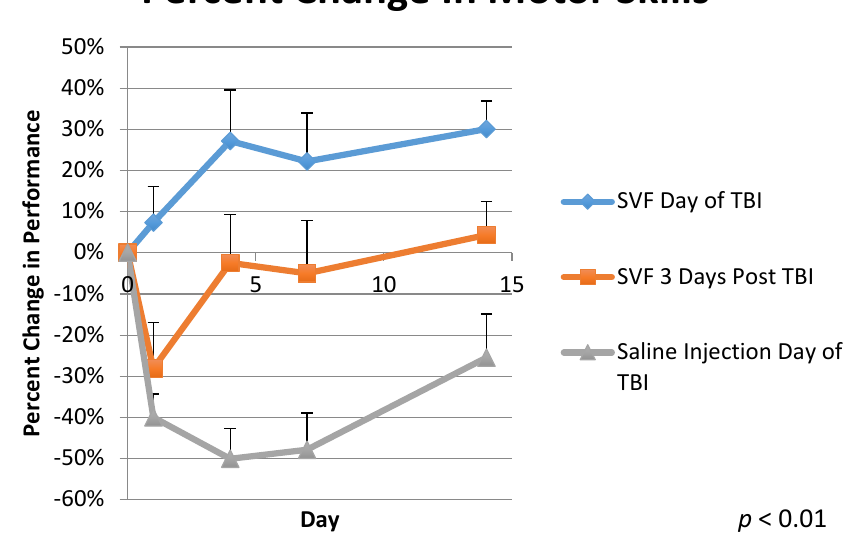
Figure 2. Percent Change in Motor Skills shows a comparison between three groups. Group 1 was treated with stromal vascular fraction the day of traumatic brain injury administration. Group 2 was treated with SVF 3 days post TBI, and Group 3 (control) was treated with Lactated Ringer’s solution the day of TBI. Behavioral testing was observed for 14 days post TBI. N = 6 for each treatment. p <